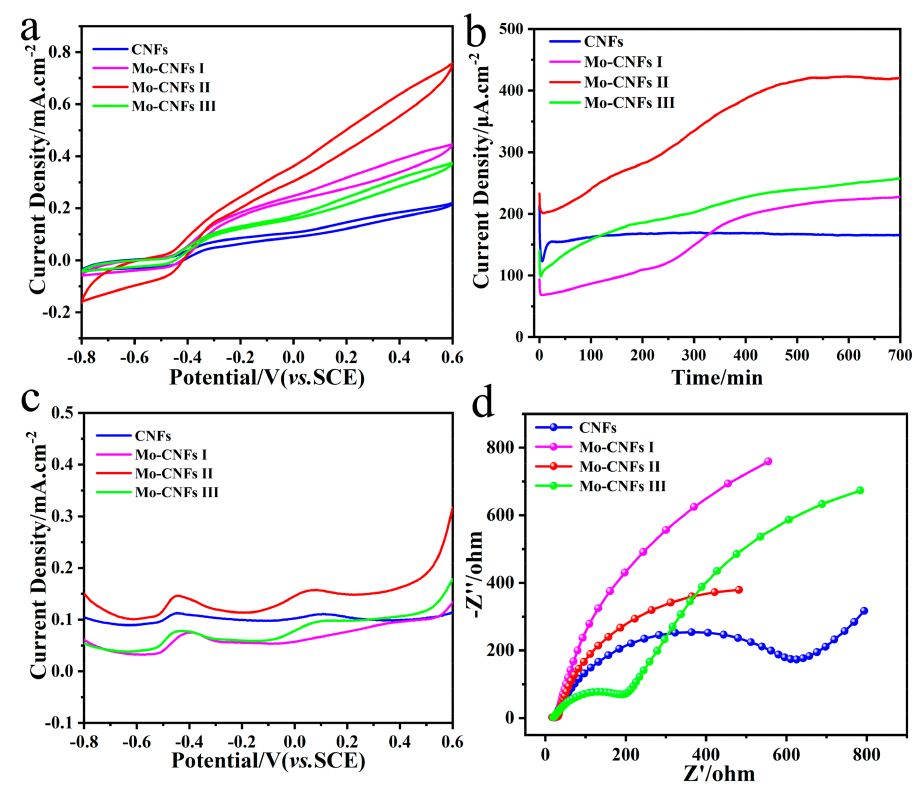
Figure 4. Different electrodes electrochemical behaviors in the S. purefaciens CN32 cell suspension.